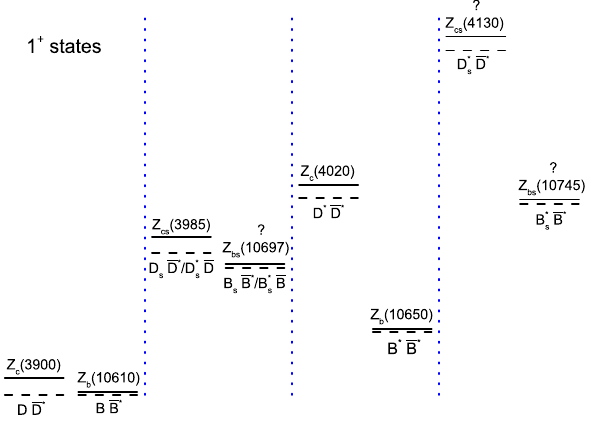
Fig. 1 The axial-vector heavy quark meson Z spectroscopy in the SU(3)-flavor symmetry and HQFS. The Z strange/strange hidden-charm and hidden-bottom states, respectively. The masses in the brackets of the states labeled in interrogation mark arefromtheoreticalexpectations[29],whiletheothersareexperimental ones